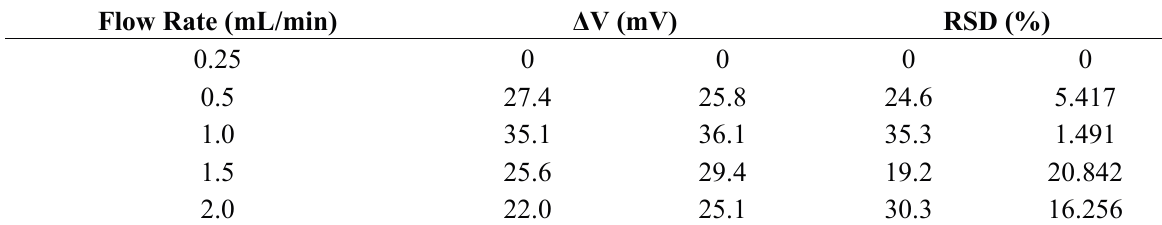
Table 1. Influence of flow rate on the thermal sensor. (Other conditions were as in Figure 2)